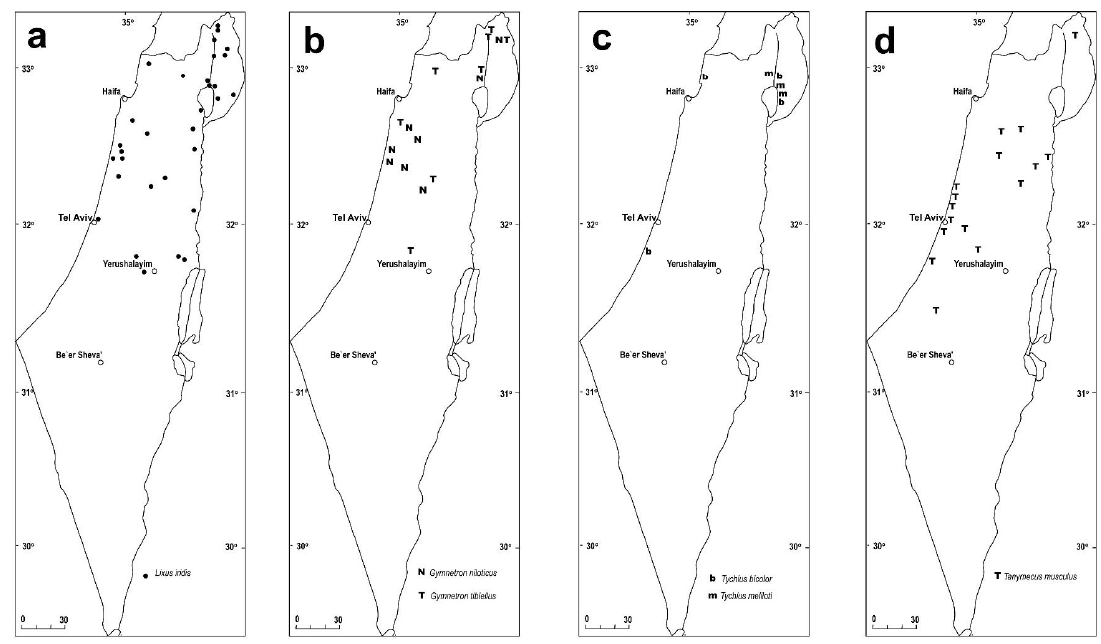
Figure 15. Distributional maps of ( a ) Lixus iridis ; ( b ) Gymnetron niloticum , G. tibiellum ; ( c ) Tychius bicolor , T. meliloti ; ( d ) Tanymecus musculus